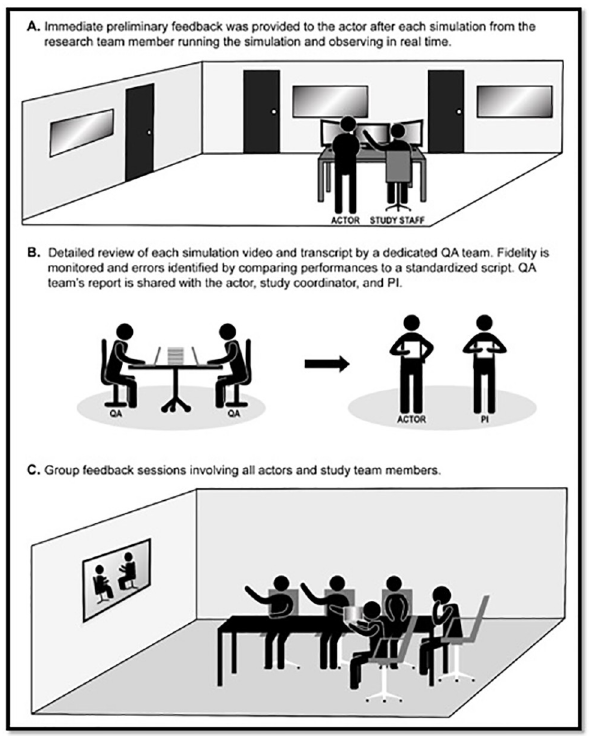
Fig 1. The three modes of feedback used to standardized actor (SFM) performances. Abbreviations: PI, Principal Investigator; QA, Quality Assurance; SFM, Standardized Family Members.